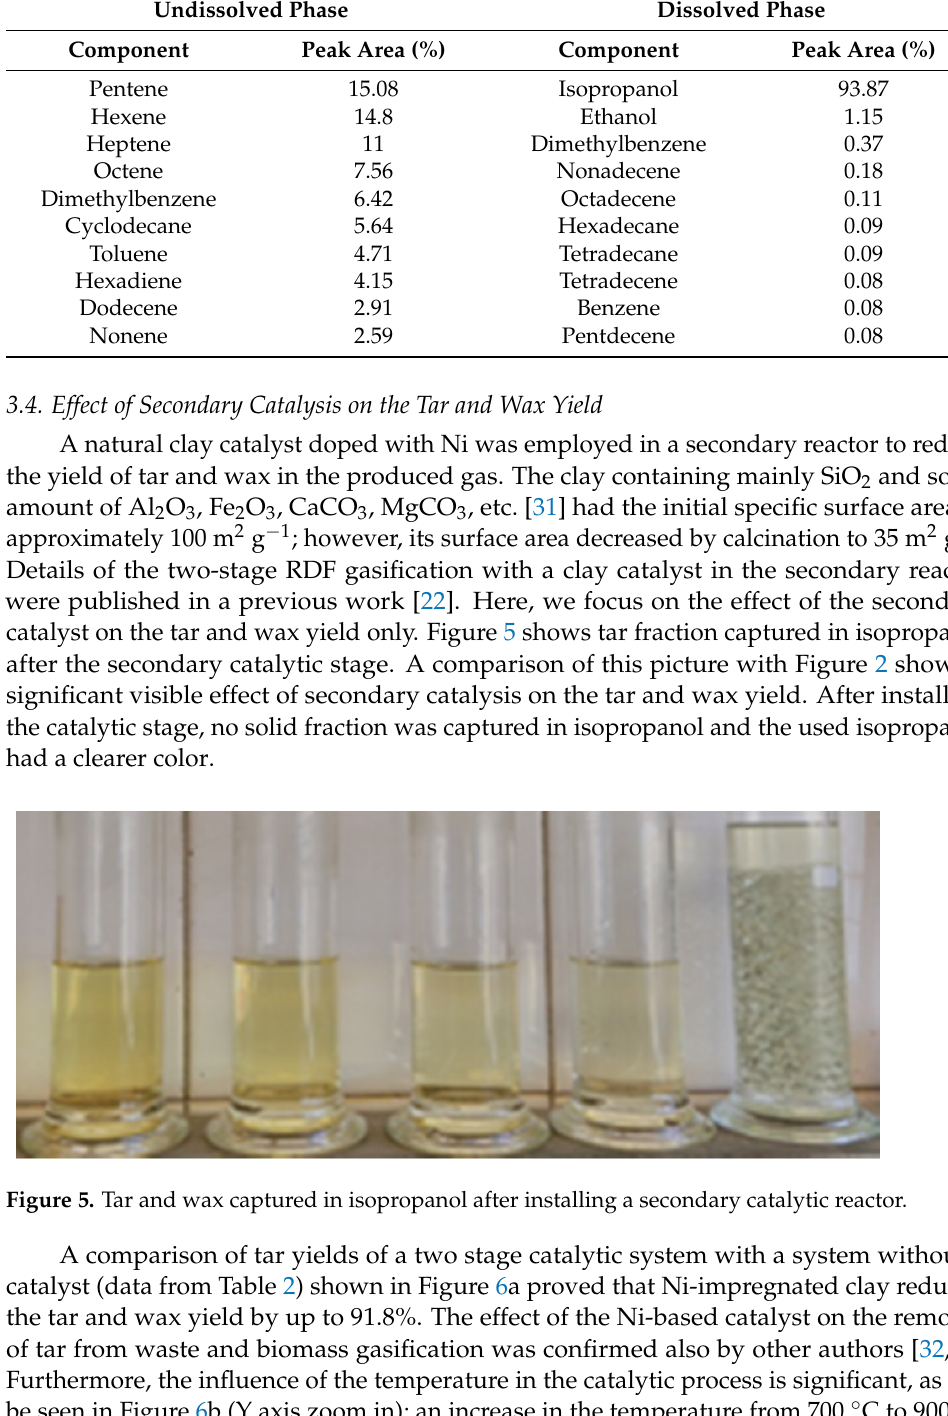
Table 4. GC-MS analysis.